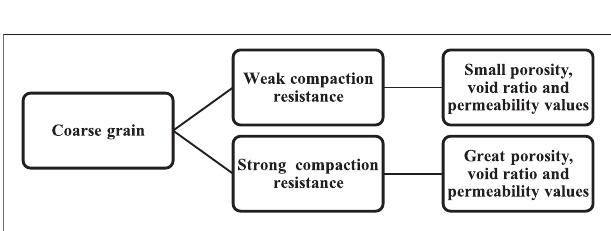
FIGURE 9 | Relationship between coarse grain, porosity, void ratio, and permeability diagram.